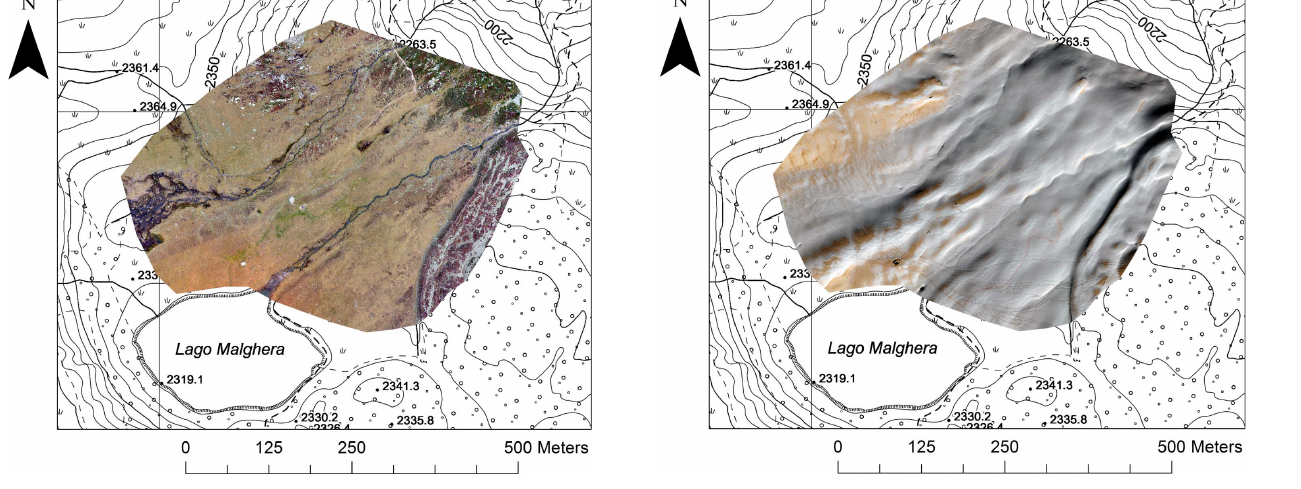
Figure 4. Orthophoto of the survey performed on 11 April